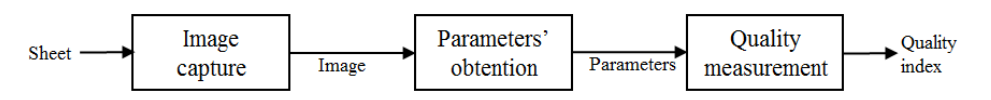
Figure 1. Complete process for the detection of the quality index.